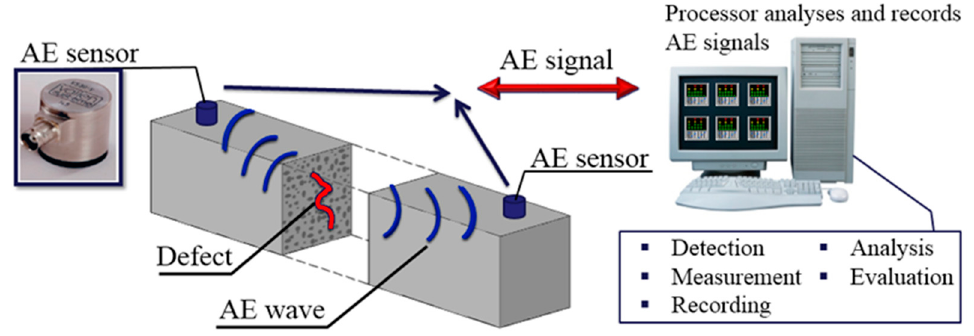
Figure 4. The concept of the method—IADP (Identification of Active Destructive Processes). Table 4. Destructive processes by the IADP (Identification of Active Destructive Processes) method.